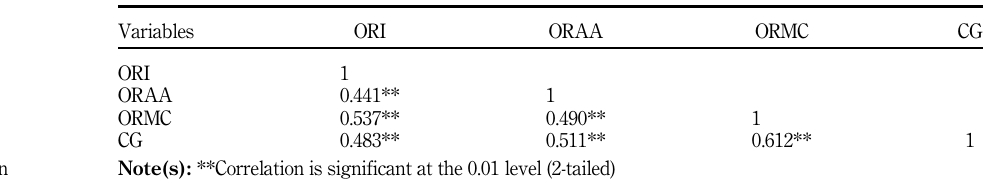
Table 4. Correlation